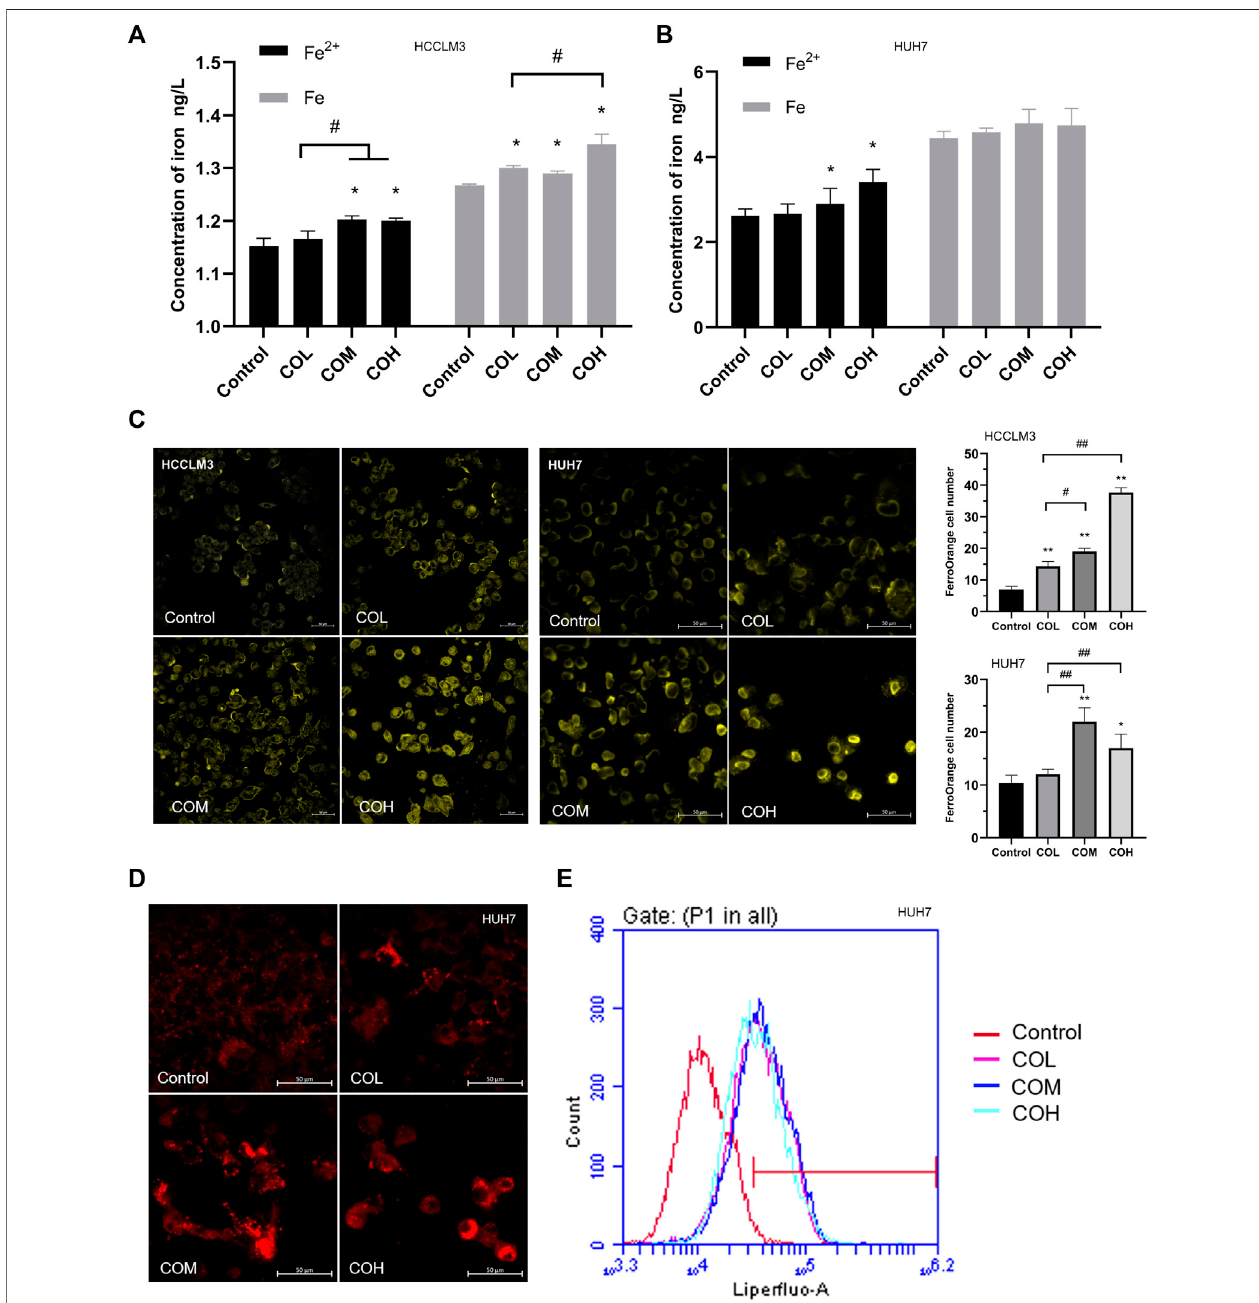
FIGURE4| Effectsofcaryophyllene oxideoniron contentandlipidperoxidationinHCCLM3andHUH7cells. (A) , (B) Ironassaykitwasusedtomeasurethelevels ofFe(totaliron)andFe 2+ inHCCLM3andHUH7cells. (C) TheintracellularfreeironinHCCLM3andHUH7cellswasdetectedusingtheFerroOrangelivingcellprobe. (D) Lipid peroxidation in HUH7 cells wasobserved using the Liper fl uo living cell probe. (E) Flow cytometry was used to measure the level oflipid peroxidation in HUH7 cells. The data were presented as mean ± SD. * p < 0.05, ** p < 0.01 when compared to the control group. # p < 0.05, ## p < 0.01 when compared to the COL group.